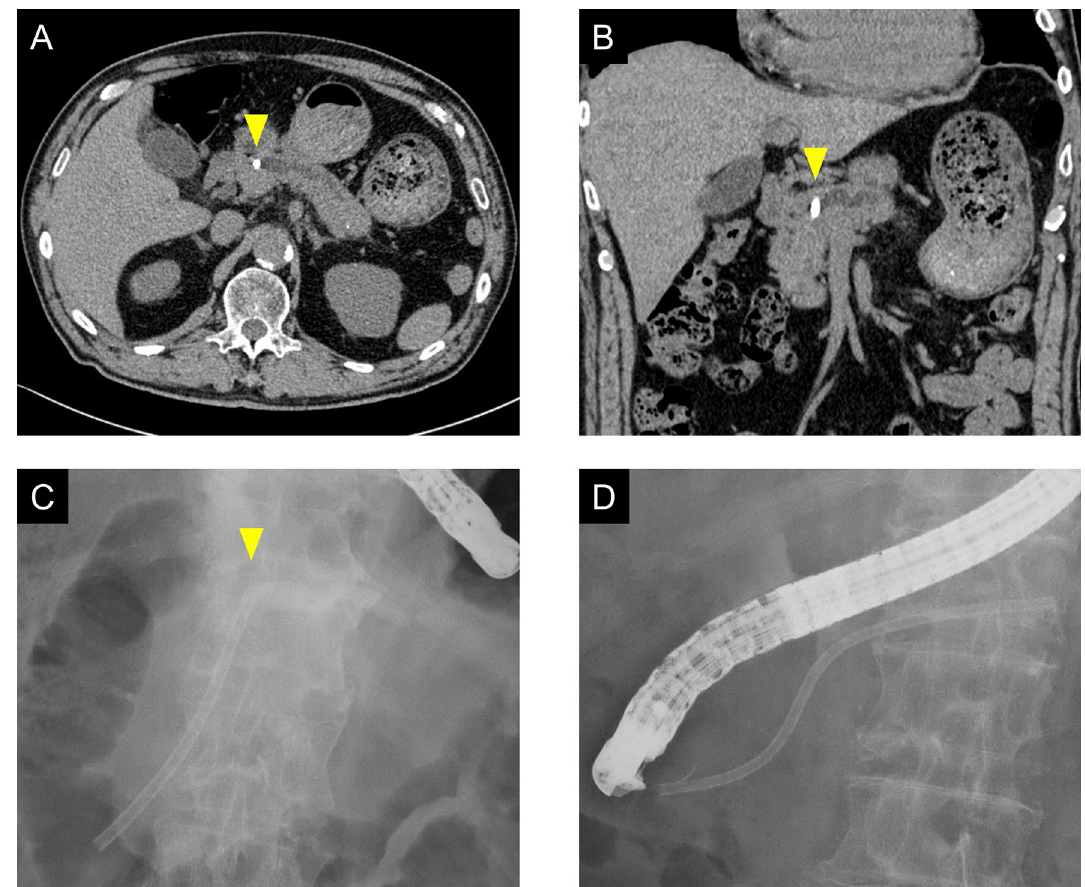
Figure 2. A 76-year-old male who received a straight-type pancreatic stent. The proximal edge of the stent became stuck at the top of the MPD in the pancreatic body (yellow triangle) and the pancreatic duct in tail was dilated ( A – C ). The physiologically shaped pancreatic stent matched the shape of the MPD ( D ). MPD, main pancreatic